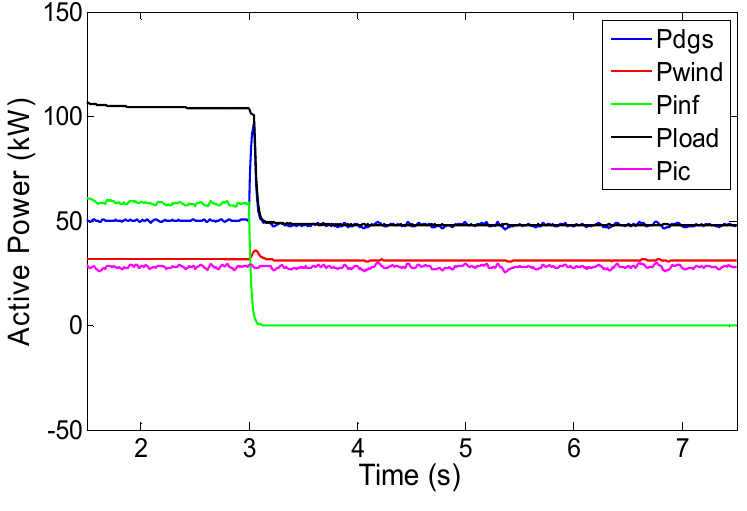
Figure 14. AC active power flow in the first case.